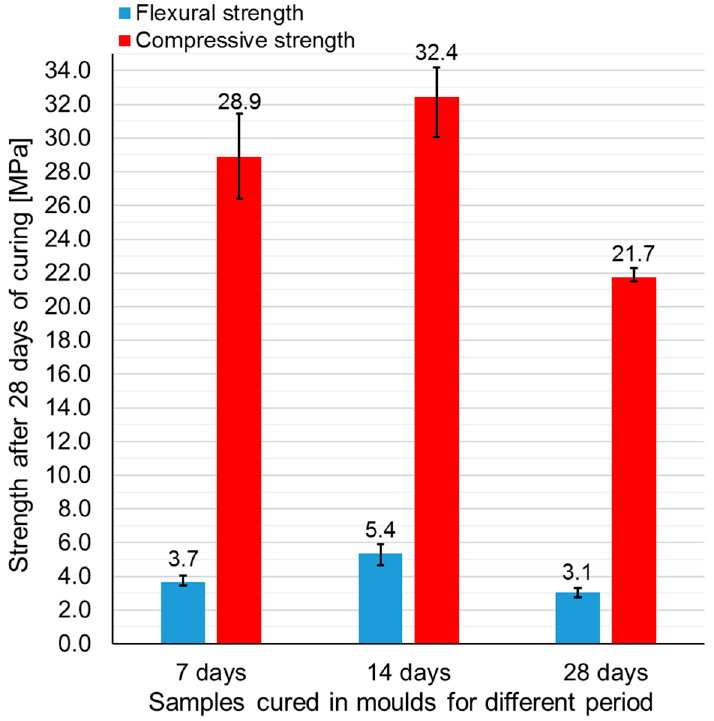
Figure 7. Flexural and compressive strength of geopolymer samples demolded after 7, 14, and 28 days of curing (mean values for all series tested). Table 6. Standard deviation and coefficient of variation of series of samples tested after 28 days and demolded after 7, 14, and 28 days.